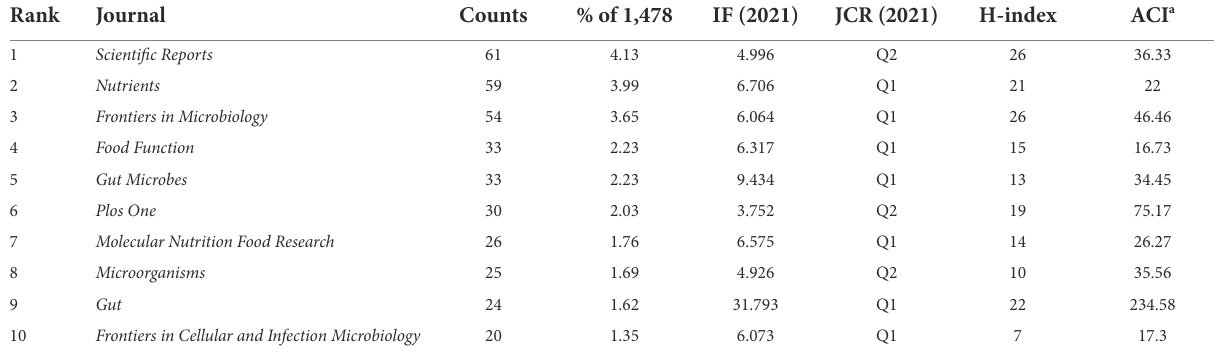
TABLE 2 Top 10 journals for A. muciniphila